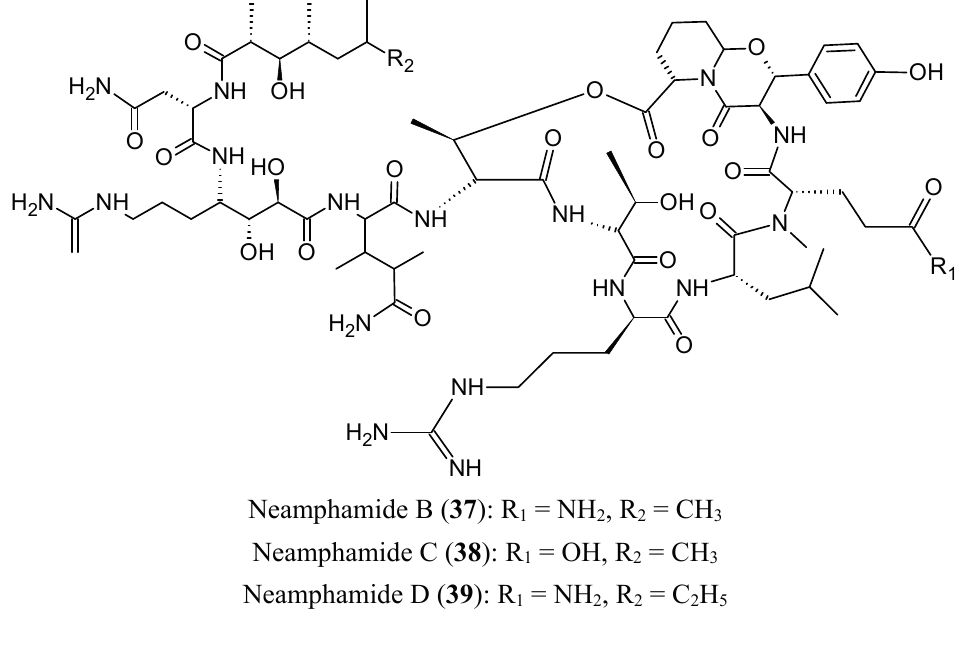
Figure 15. Neamphamides B, C and